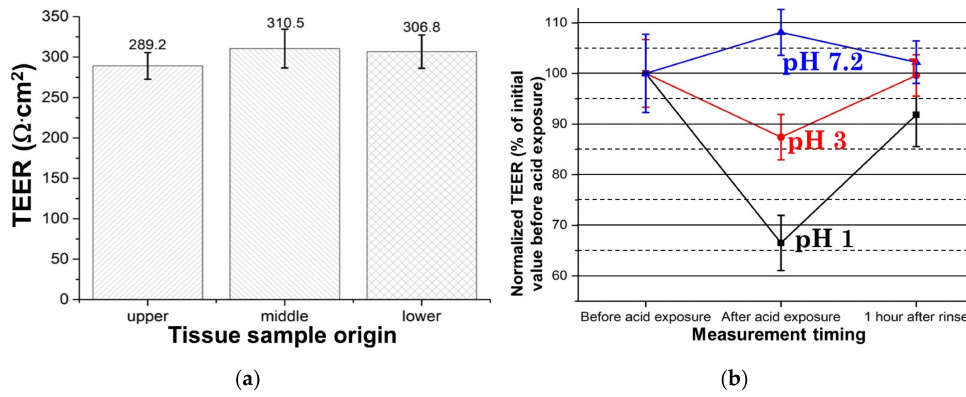
Figure 3. TEER measured values using the “sandwich ring” method: ( a ) TEER values from upper, middle, and lower thoracic porcine esophagus, respectively. The p -value = 0.0954 ( n ≥ 5) for our obtained data set shows that no statistically significant di ff erence exists between the results for the samples from the upper and middle esophagus; ( b ) TEER changes in the tissue specimens exposed for 20 min. to environments of various pH values and after a 1 h recovery ( n = 4). Irreversible damage was induced on the tissue treated with the pH 1 medium. (The numerical values for the data shown in Figure 3a,b can be found in Table S10 in the Supplementary